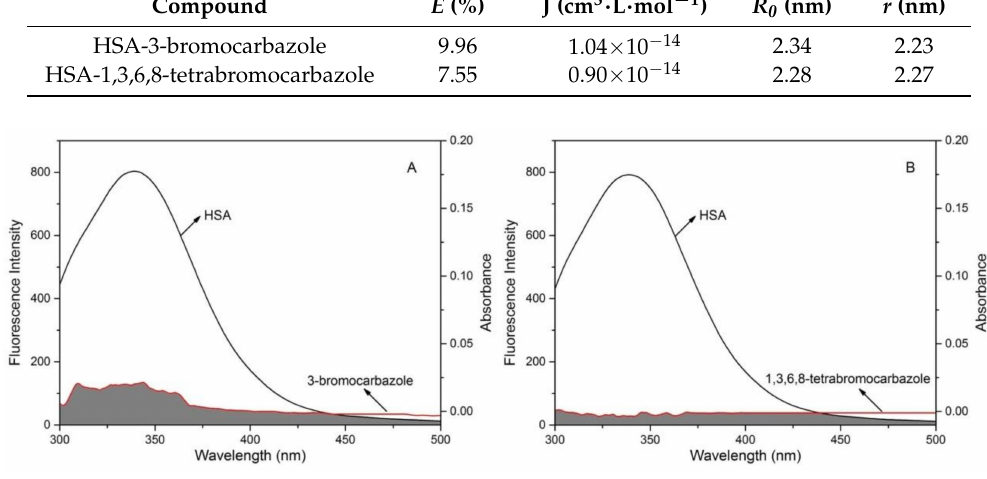
Figure 8. The overlaps of HSA fluorescence spectra and 1,3,6,8-tetrabromocarbazole or 3-bromocarbazole absorption spectra. ( A ): HSA-3-bromocarbazole; ( B ):